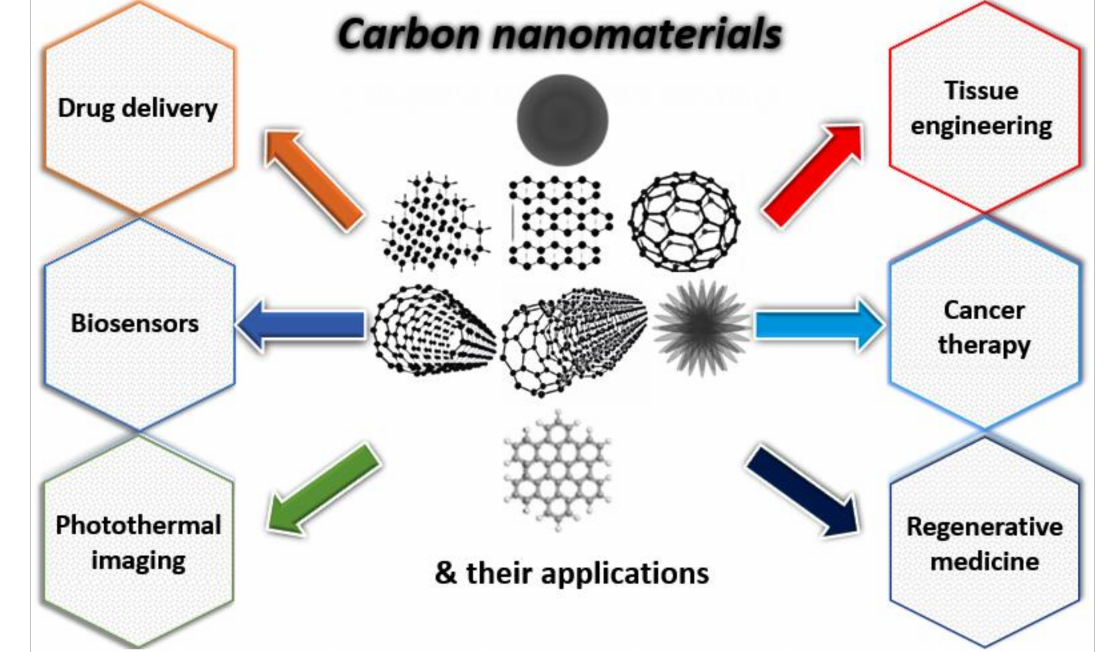
Figure 1. Carbon nanomaterials and their applications in the vast biomedical arena.